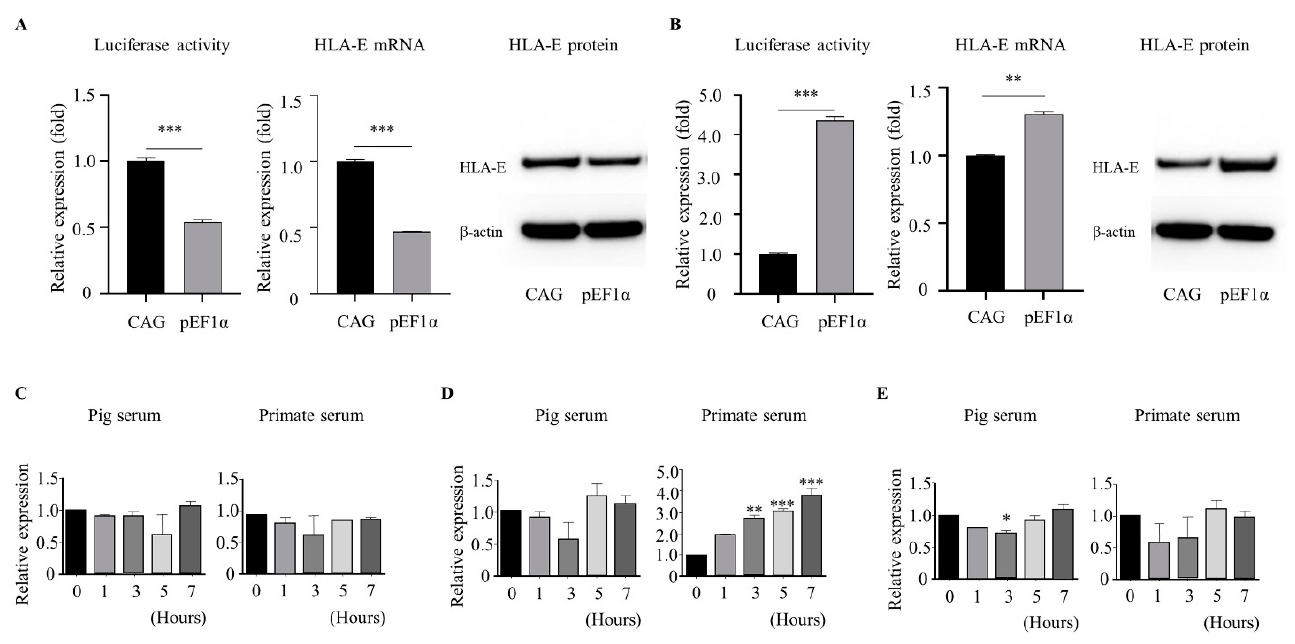
Figure 4. The pEF1 α promoter mediates significant increases in heterologous gene expression in response to primate serum in PAECs. ( A ) Luciferase activity, mRNA expression levels, and protein expression levels of HLA-E transgenes in PAECs transiently transfected with the expression cassettes presented in Figure 3A, followed by incubation in culture medium supplemented with pig serum. ( B ) Luciferase activity, mRNA expression levels, and protein expression levels of HLA-E transgenes in transfected PAECs incubated in culture medium supplemented with primate serum. ( C – E ) Expression pattern of endogenous pEF1 α ( C ), TF ( D ), and ICAM2 ( E ) in PAECs cultured with porcine serum and primate serum for 1, 2, 3, 5, and 7 h. CAG, cytomegalovirus enhancer/chicken β -actin promoter; pEF1 α , porcine elongation factor 1 α ; HLA, human leukocyte antigen E; ICAM2 , intercellular adhesion molecule 2; TF , tissue factor. Values are means ± SEM calculated from three replicates. *, p < 0.05; **, p < 0.01; ***, p < 0.001.